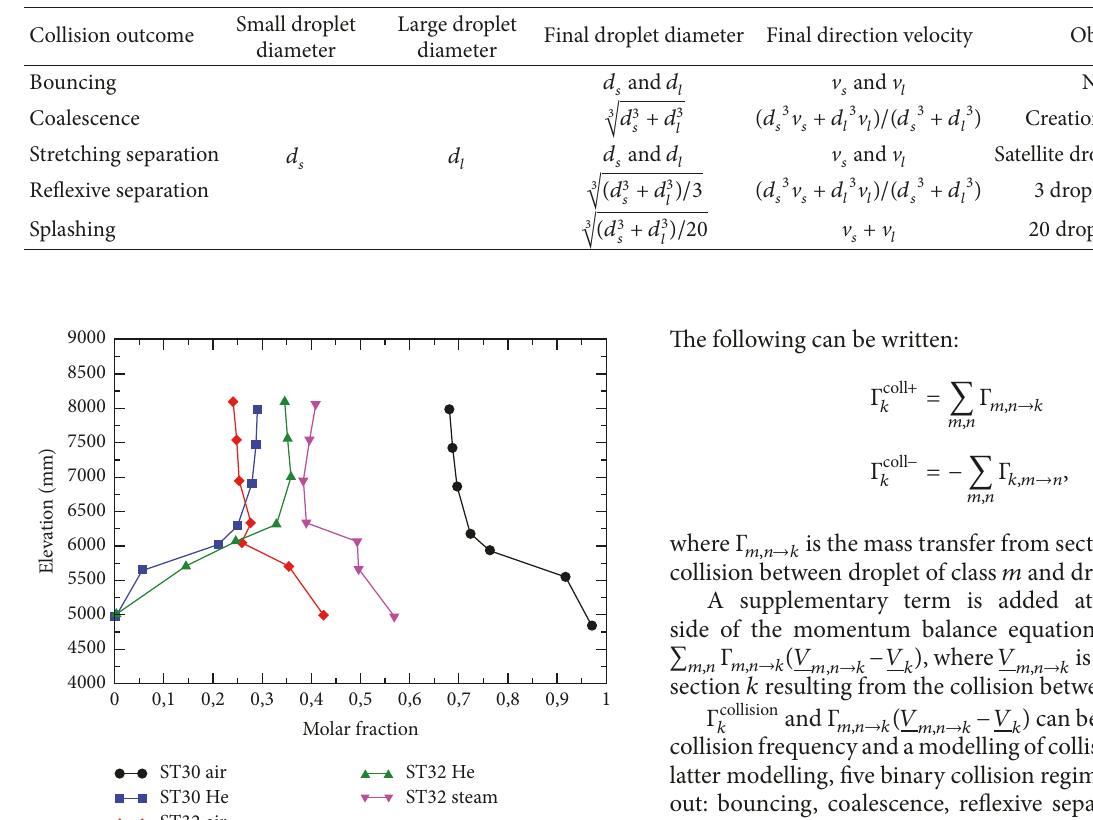
Table 4: Daughter droplets diameters of two parents droplets after a binary collision for different regimes.